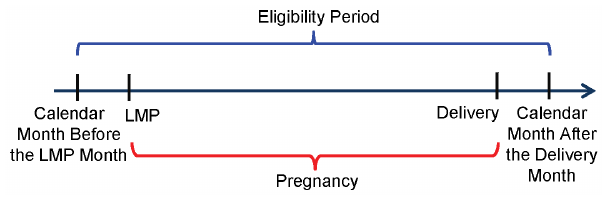
Figure 3. Schematic of the primary eligibility period.